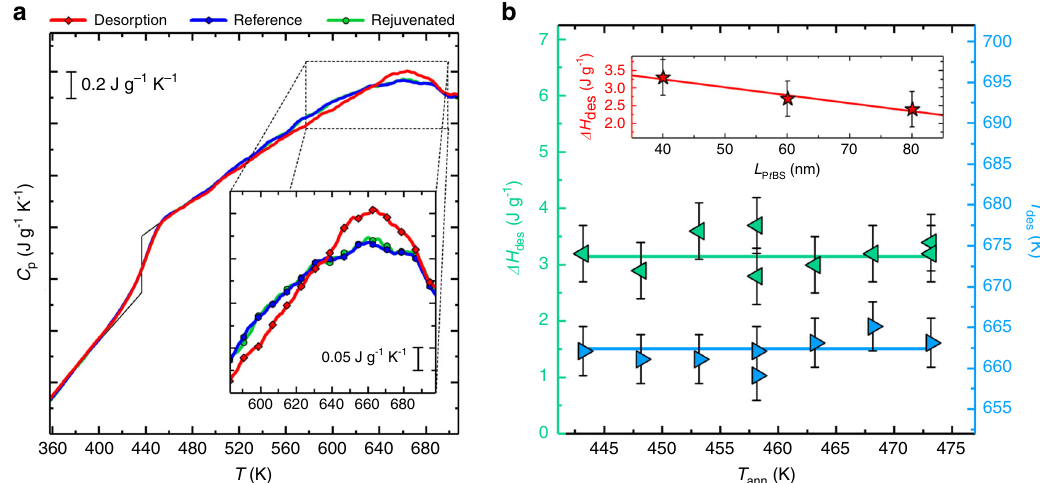
Fig. 2 Desorption transition in P t BS thin fi lms. a Heating scans at 10 4 K s − 1 after annealing at 458 K for 5 × 10 4 s (red curves), before adsorption (reference, blue curves) and after desorption (rejuvenated, green curves). Black lines at about 440 K highlight the step in the speci fi c heat associated with the glass transition. The inset of a is an enlargement in the temperature range where desorption takes place. b Enthalpy of desorption (left triangles) and temperature of the maximum of the endothermic overshoot (right triangles) as a function of the annealing temperature. The inset of panel b shows the enthalpy of desorption after annealing for 5 × 10 4 s at 458 K as a function of the fi lm thickness. Error bars account for the uncertainty in the determination of the temperature maximum ( T des ) and intensity ( Δ H des ) of the